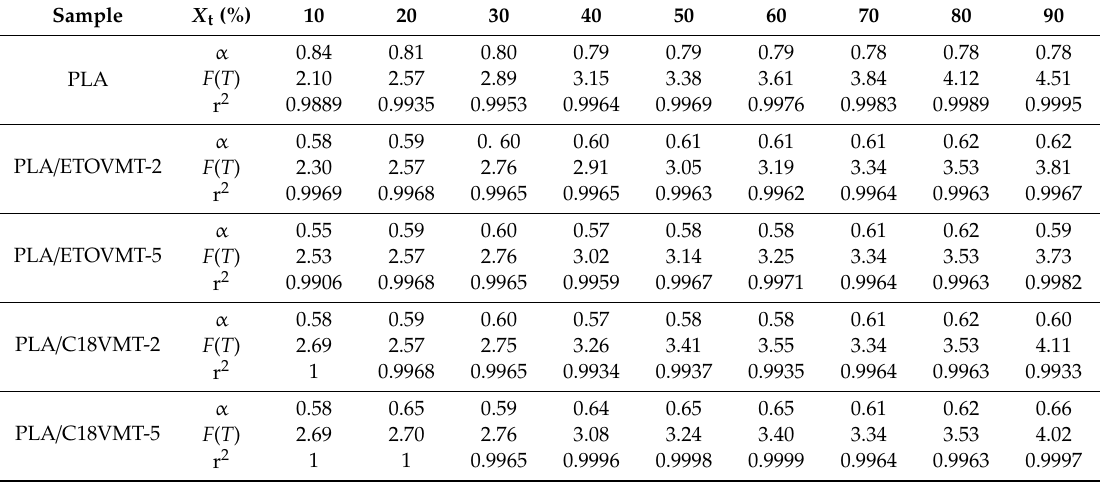
Table 3. The non-isothermal crystallization kinetic parameters based on the Mo model for PLA and PLA / VMT nanocomposites.